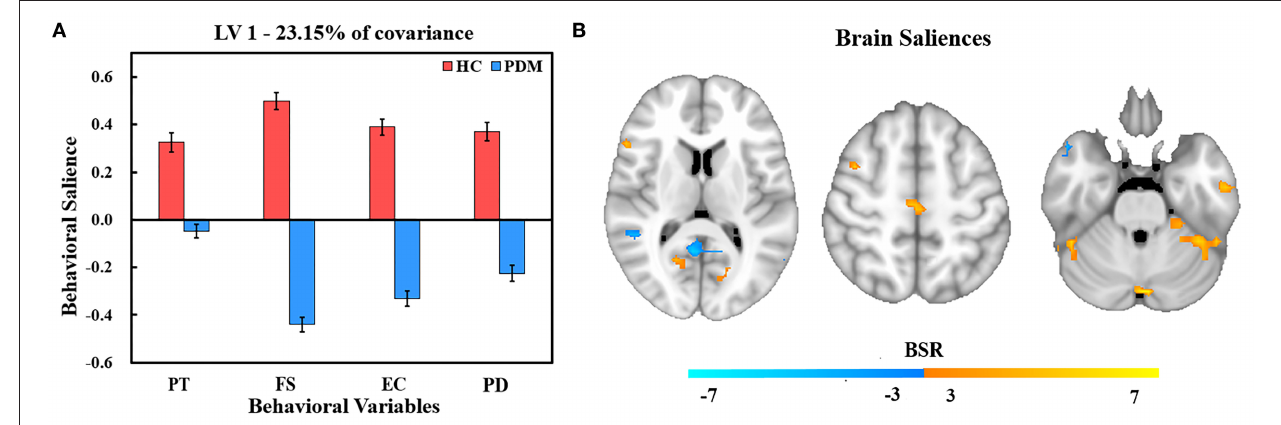
FIGURE 1 | PLS correlation analysis results of LV 1. (A) Bar graph of behavioral salience with stability estimated using the bootstrap method in the two studied groups. (B) Resting brain activity showing brain regions in which variations were associated with trait empathy. The map is generated with the threshold set at p = 0.01 (BSR = ± 3). In the HC group, warm regions indicated a positive correlation between resting brain activity, empathy scores, and cool regions showed a negative correlation between the resting brain activity and empathy scores. In contrast, the association was reversed in the PDM group (warm, negative correlation; cool, positive correlation). PT, perspective taking; FS, fantasy; EC, empathic concern; PD, personal